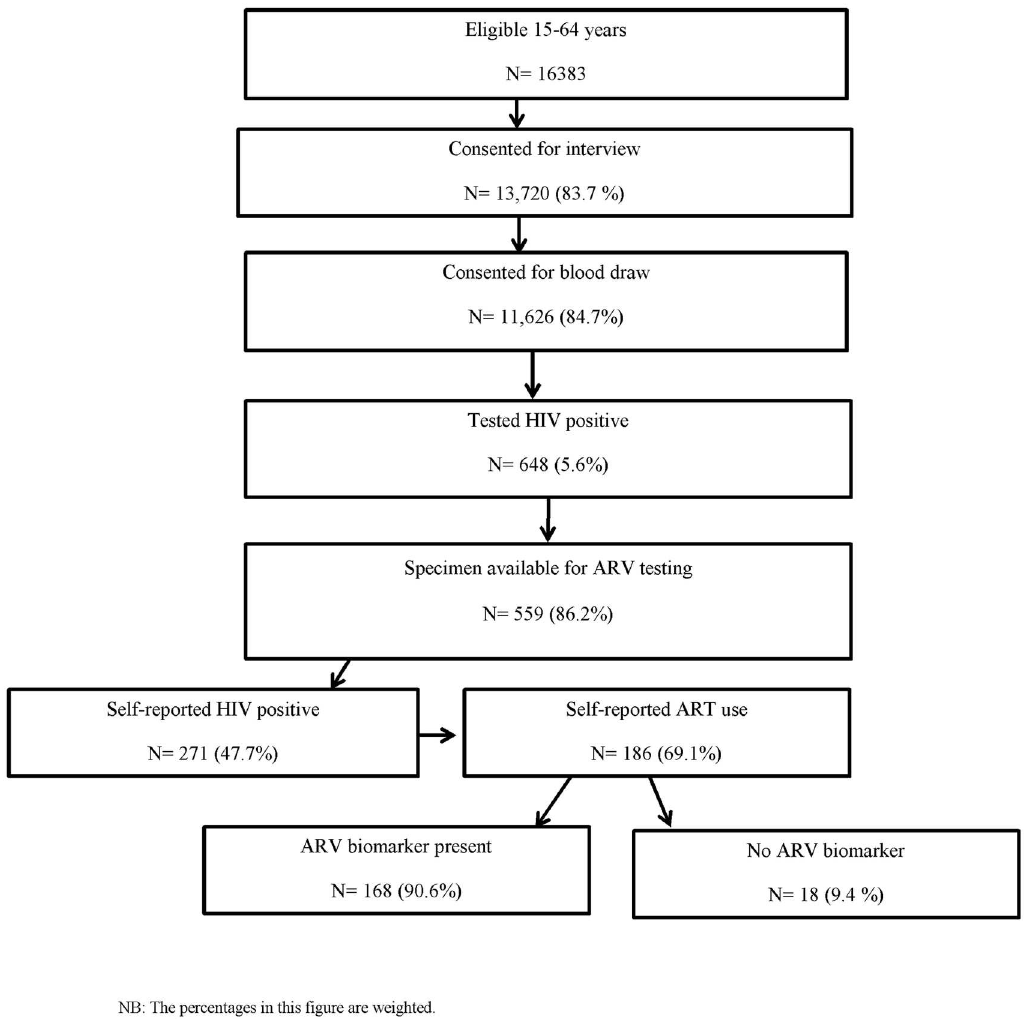
Fig 1. Analysis flow chart among adults and adolescents aged 15–64 yearsin the Kenya AIDS indicator Survey 2012. The figure presents the flow of how eligiblepersons for this analysiswere derived from the overal Kenya AIDS Indicator Survey. Percentagesin this figure are weighted.ART, antiretroviral therapy; ARV,